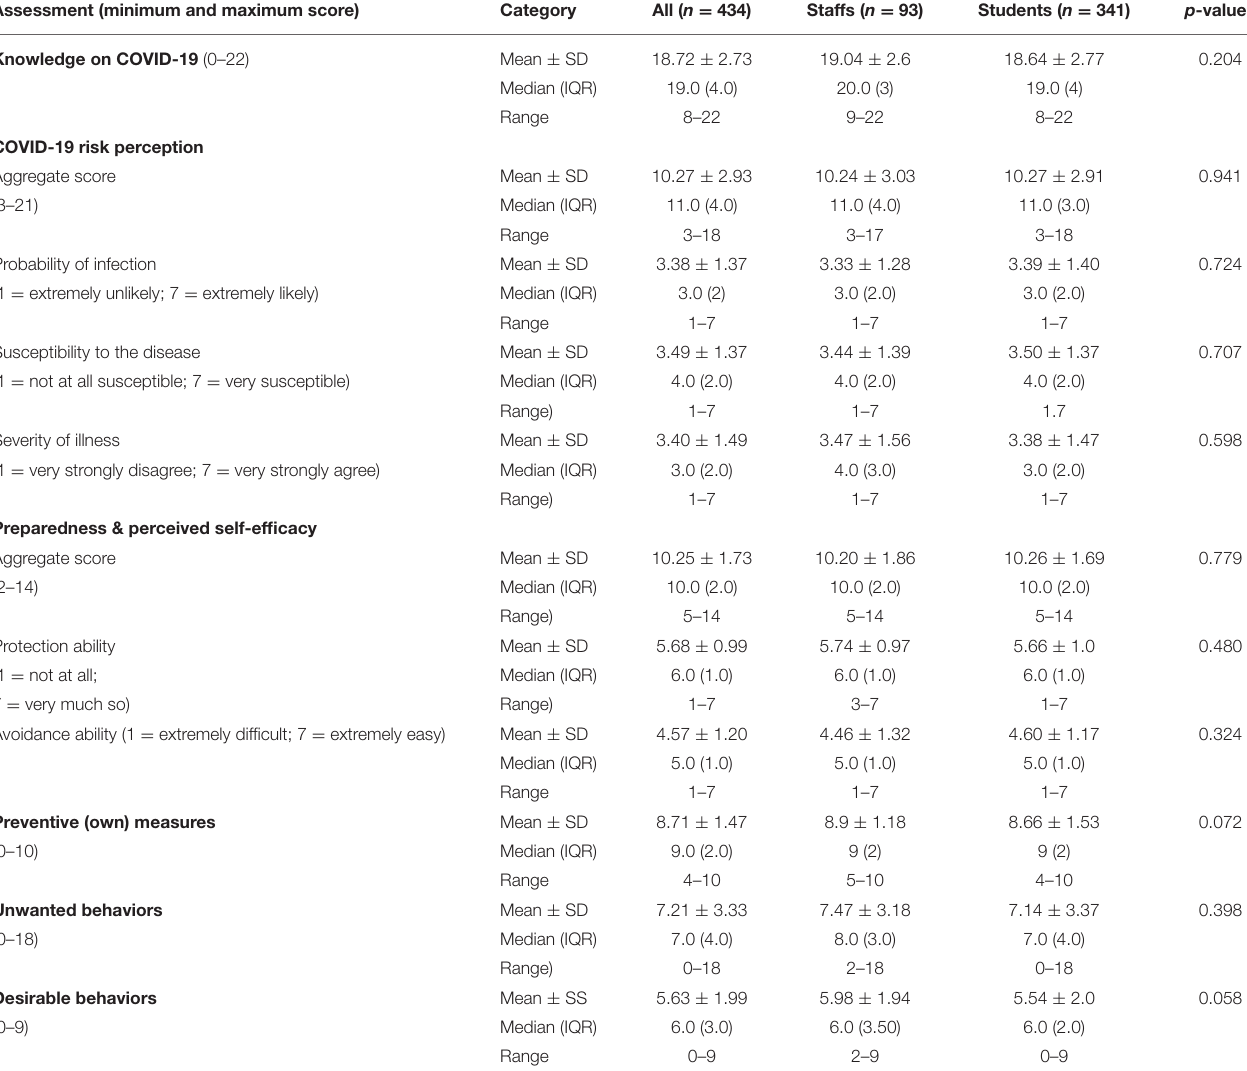
TABLE 2 | Summary of results on knowledge, risk perception, preparedness & perceived self-efficacy, preventive measures, and behavior related to COVID-19 ( n = 434). Assessment (minimum and maximum score)